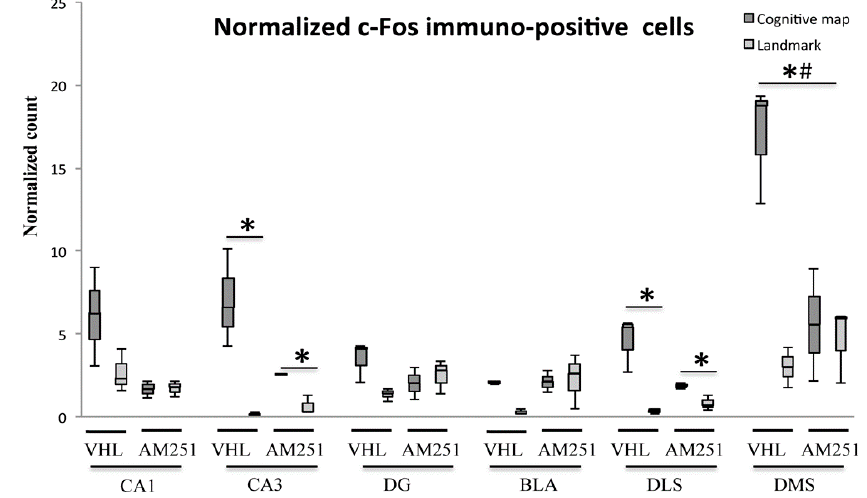
Figure 7. Comparison of normalized c-Fos activations in hippocampal CA1 and CA3 and dentate gyrus (DG), basolateral amygdala (BLA) and dorsolateral (DLS) and dorsomedial (DMS) striatum exhibited by animals injected with vehicle (VHL) or AM251 according to the landmark- or cognitive